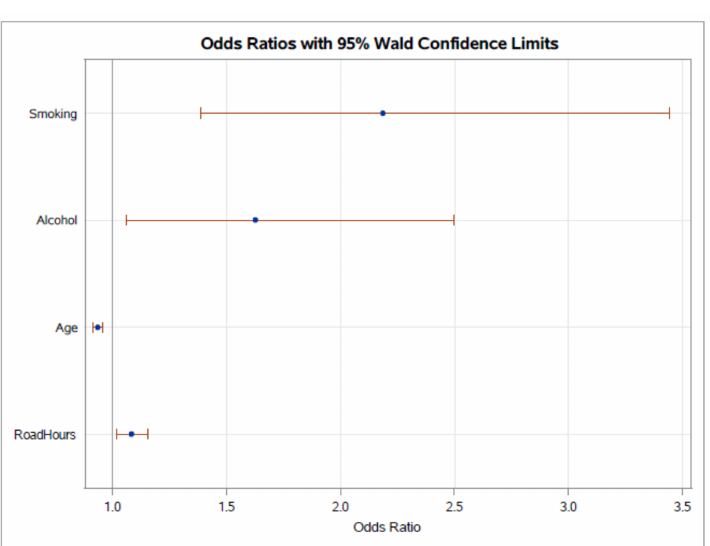
Figure 1. Odds ratio chart for the independent variables of smoking, alcohol consumption, age and hours of driving per day in the logistic regression analysis for the dependent variable, illicit